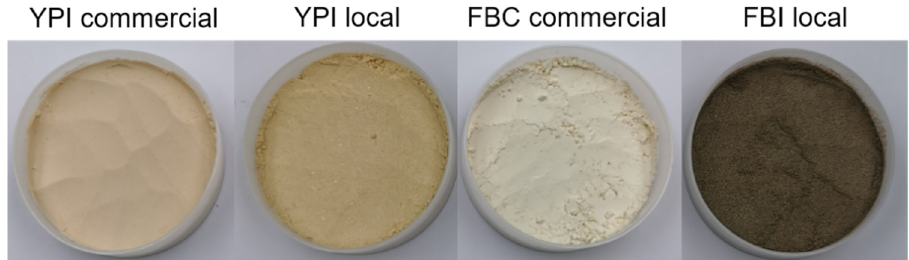
Figure 2. Appearance of the different types of pulse protein isolates/concentrate. YPI = yellow pea isolate, FBC = faba bean concentrate, FBI = faba bean isolate.